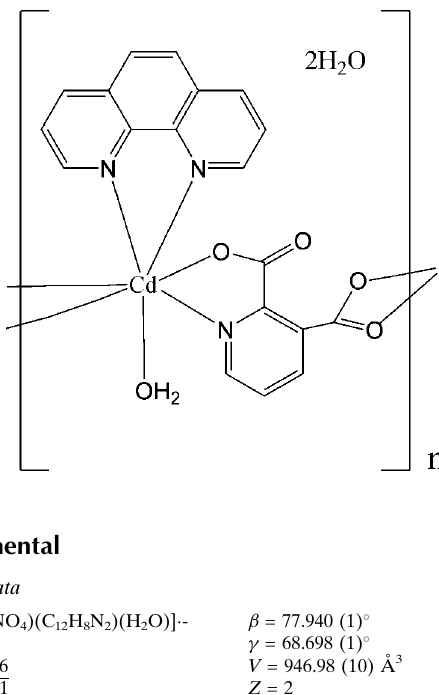
Key indicators: single-crystal X-ray study; T = 293 K; mean (cid:1) (C–C) = 0.003 A˚; disorder in solvent or counterion; R factor = 0.019; wR factor = 0.048; data-to- parameter ratio = 15.4.